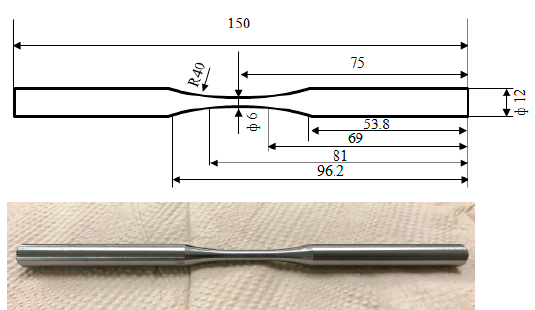
Figure 1. Geometry dimensions and photo of rotating bending fatigue test specimen which used in this study.